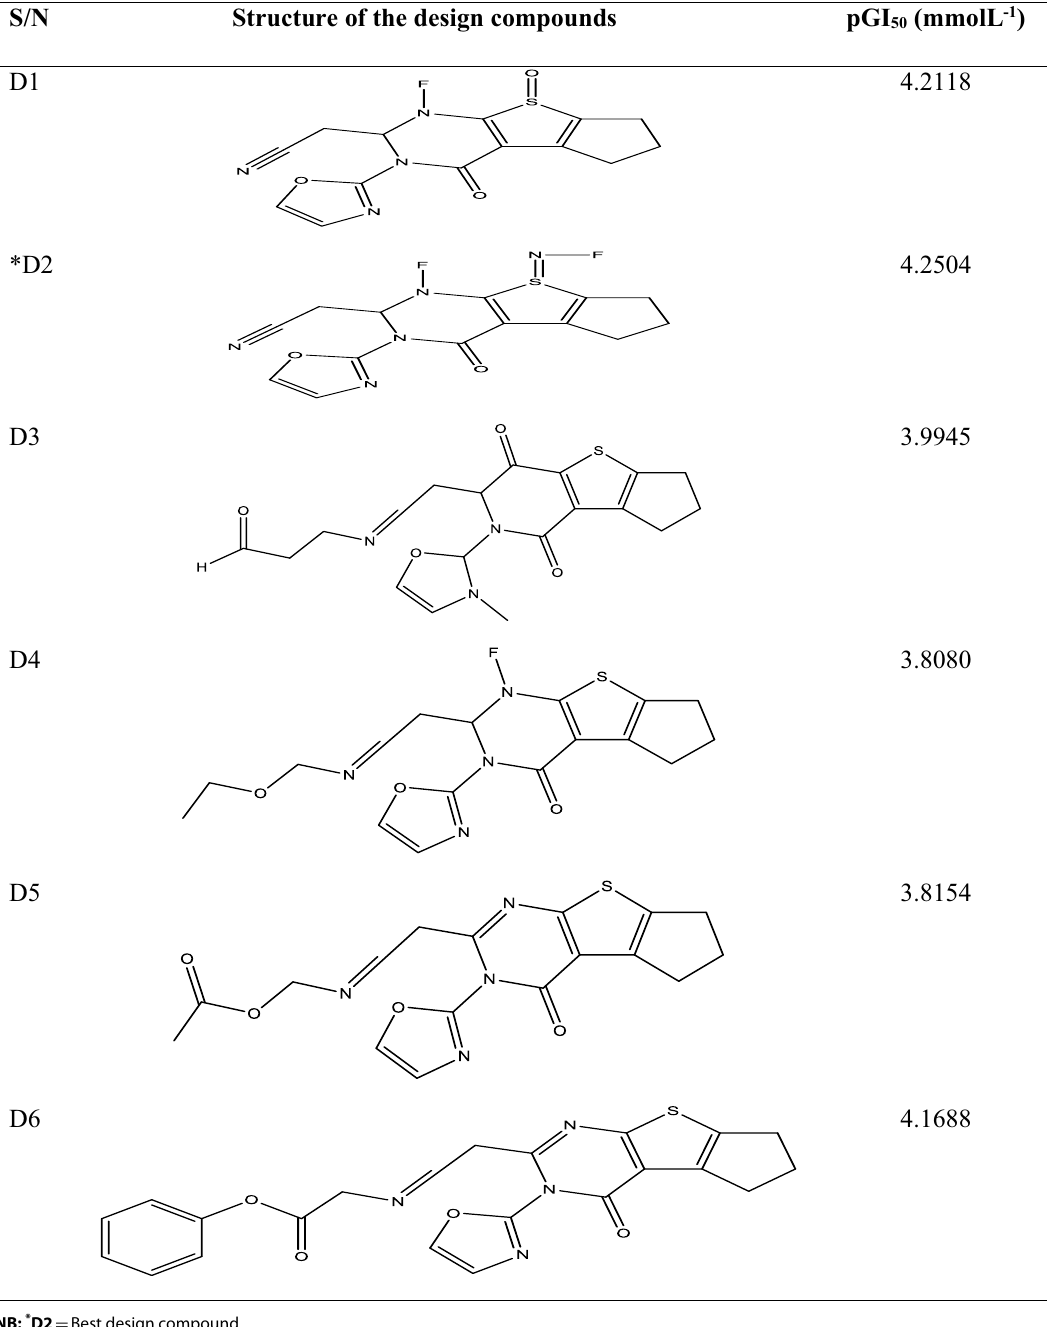
Table 9 2D Structures and 50% Growth Inhibitory activities (pGI